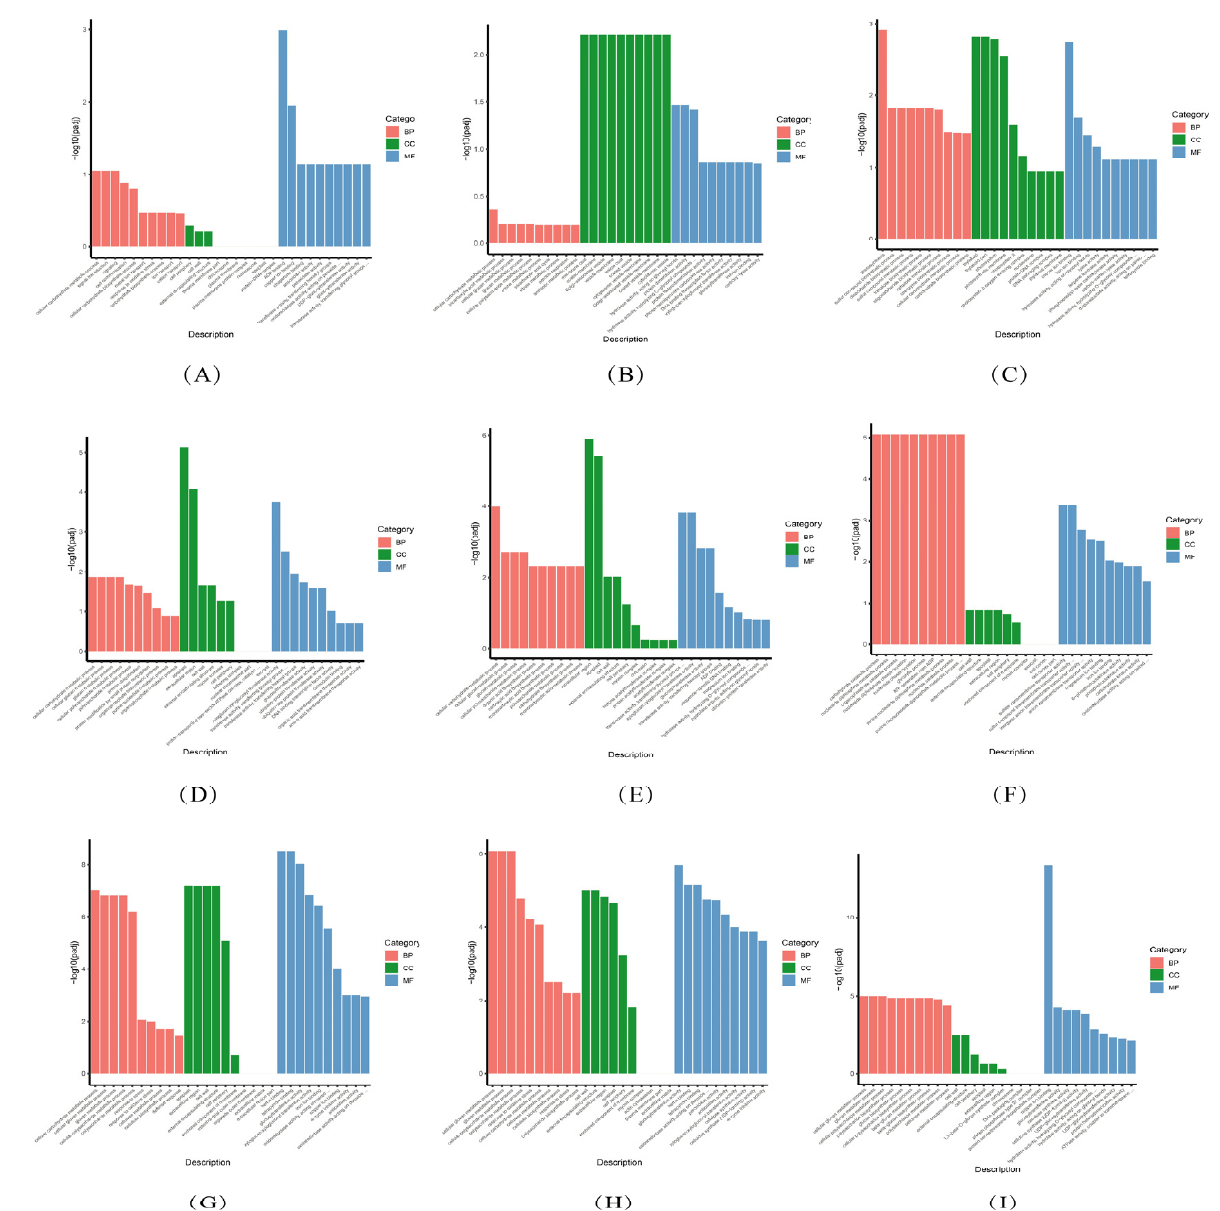
Figure 7. GO enrichment analysis of differentially expressed genes in each comparison group of leaf, stem and root. ( A ) L200 vs. L0; ( B ) L400 vs. L0; ( C ) L400 vs. L200; ( D ) S200 vs. S0; ( E ) S400 vs. S0; ( F ) S400 vs. S200; ( G ) R200 vs. R0; ( H ) R400 vs. R0; ( I ) R400 vs. R200.